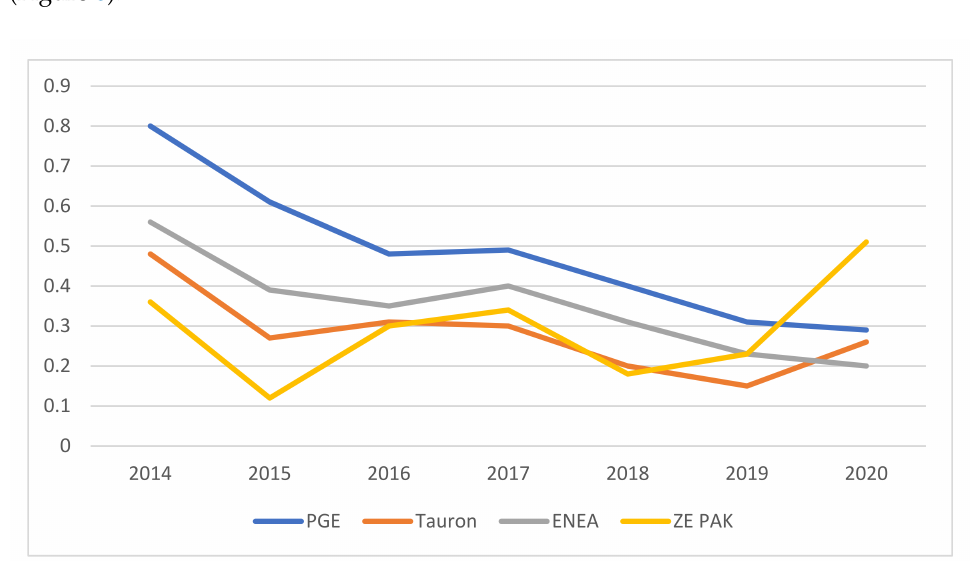
Figure 6. Group functioning efficiency (P/BV) (Own study based on Warsaw Stock Exchange statistics for